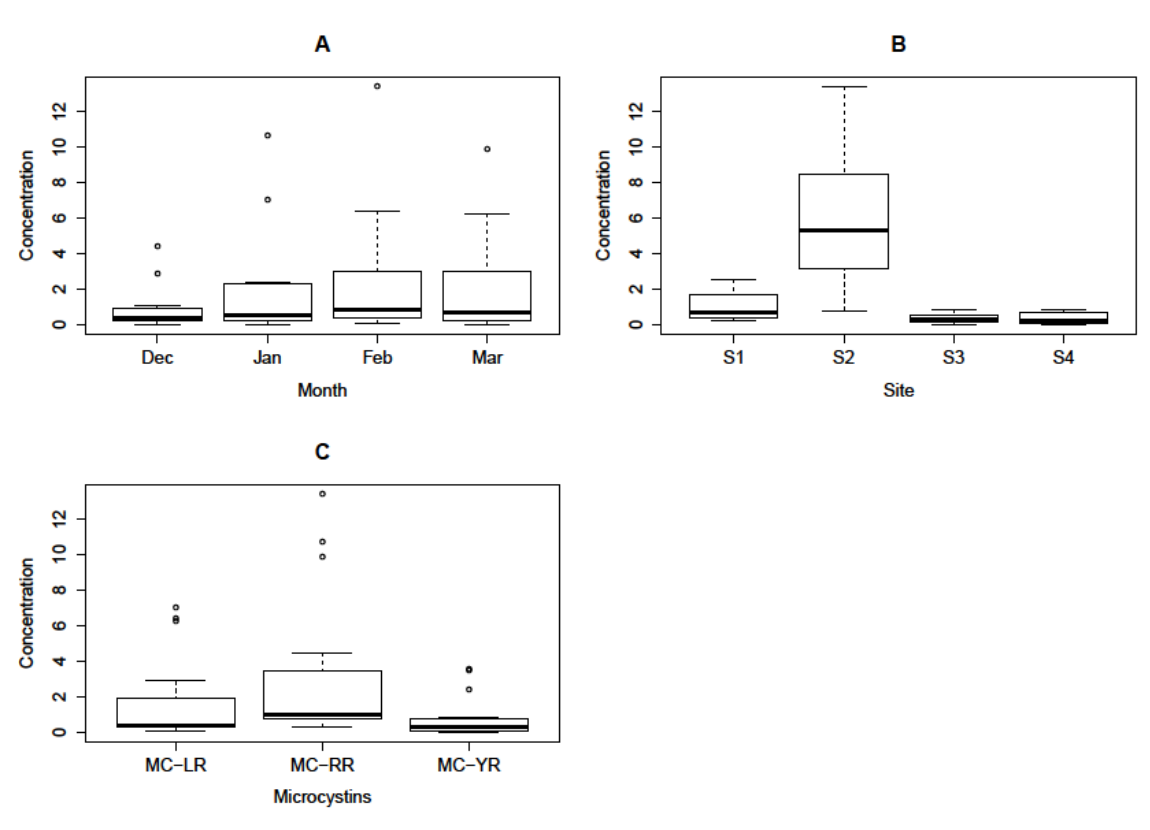
Figure 3. One-way ANOVA presentation of the statistical differences of mean MC concentrations (µg/g DWx20) for a study conducted between December and March. ( A ) Across months: No significant differences ( P = 0.62). ( B ) Across sites: High significant difference ( P < 0.001). ( C ) Among MC congeners: Marginal significant difference ( P = 0.060).